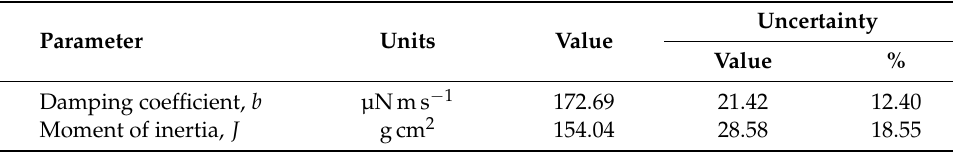
Table 3. Results for the damping coefficient and moment of inertia tests.